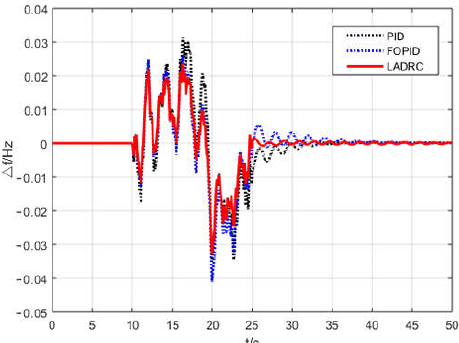
Figure 7. The system frequency variation chart under random disturbance.